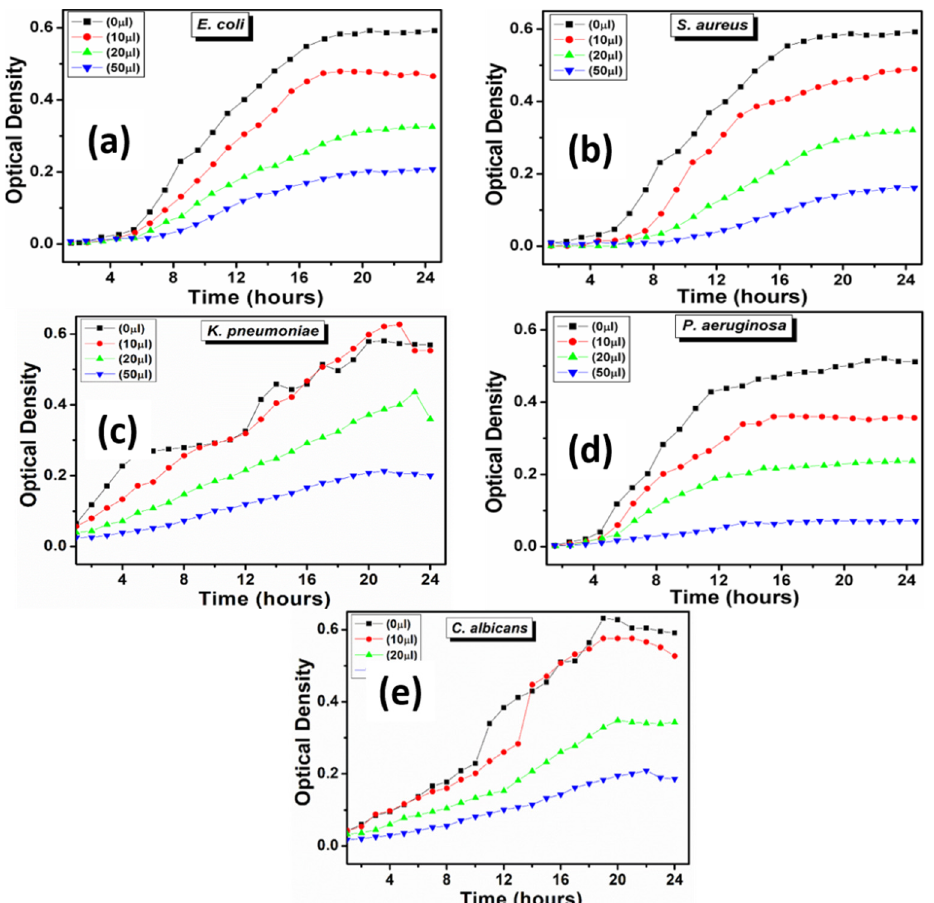
Figure 5. Growth curves of ( a ) E. coli , ( b ) S. aureus, and ( c ) K. pneumoniae , ( d ) P. aeruginosa , ( e ) C. albicans in the presence of silver nanoparticles.